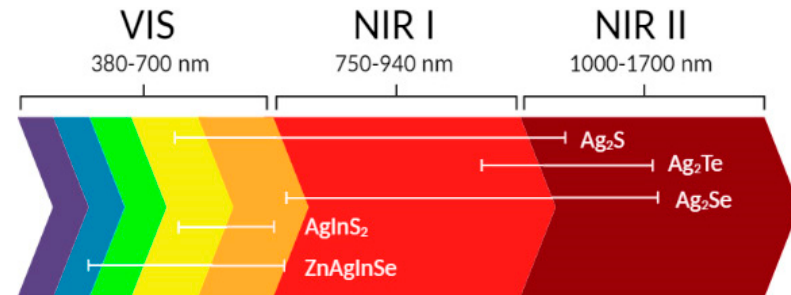
Figure 1. Emission wavelength range of Ag-based QDs.